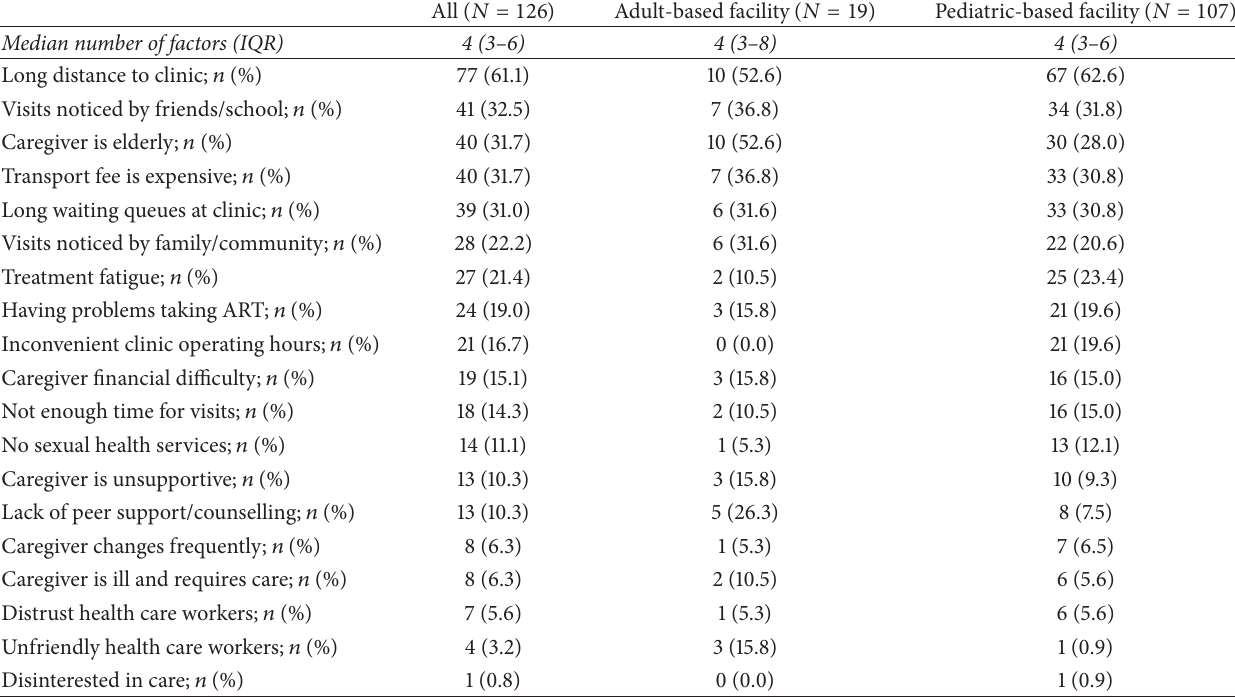
Table 2: Frequency of reported factors, overall and by